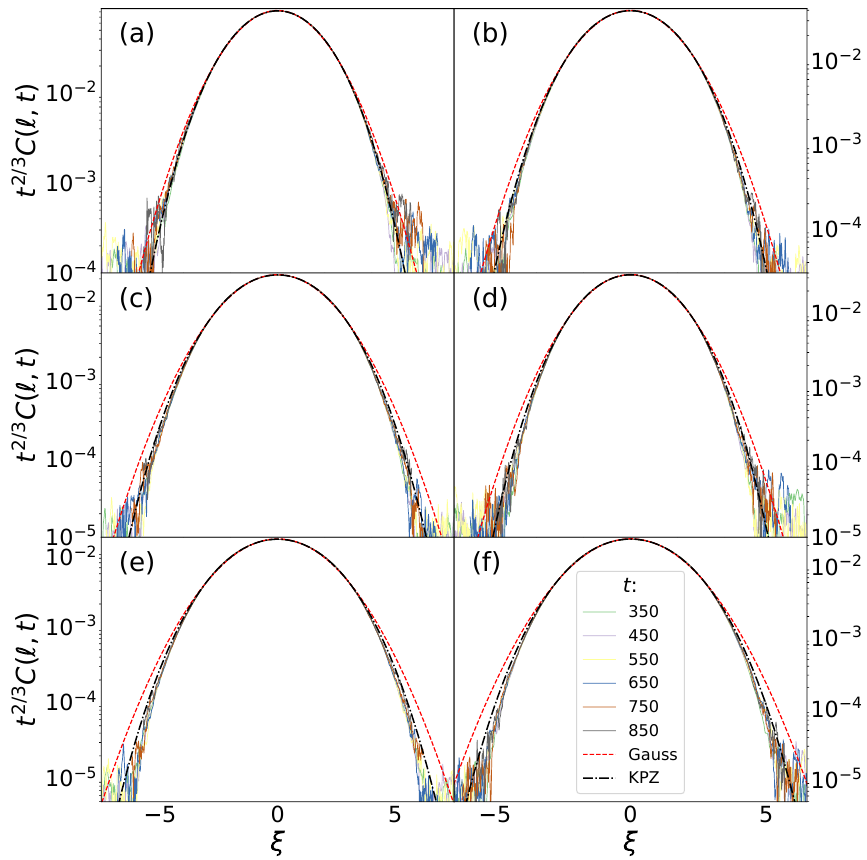
Figure 7: Convergence to the stationary cross sections of the scaled dynamical struc- ( ξ , t ) , fitted with the KPZ universal function g ture factors (cid:101) C q for the corresponding datasets shown in Fig. 5. In comparison, the red dashed lines display the best fit with a Gaussian profile (red dashed curve), showing systematic deviations in the